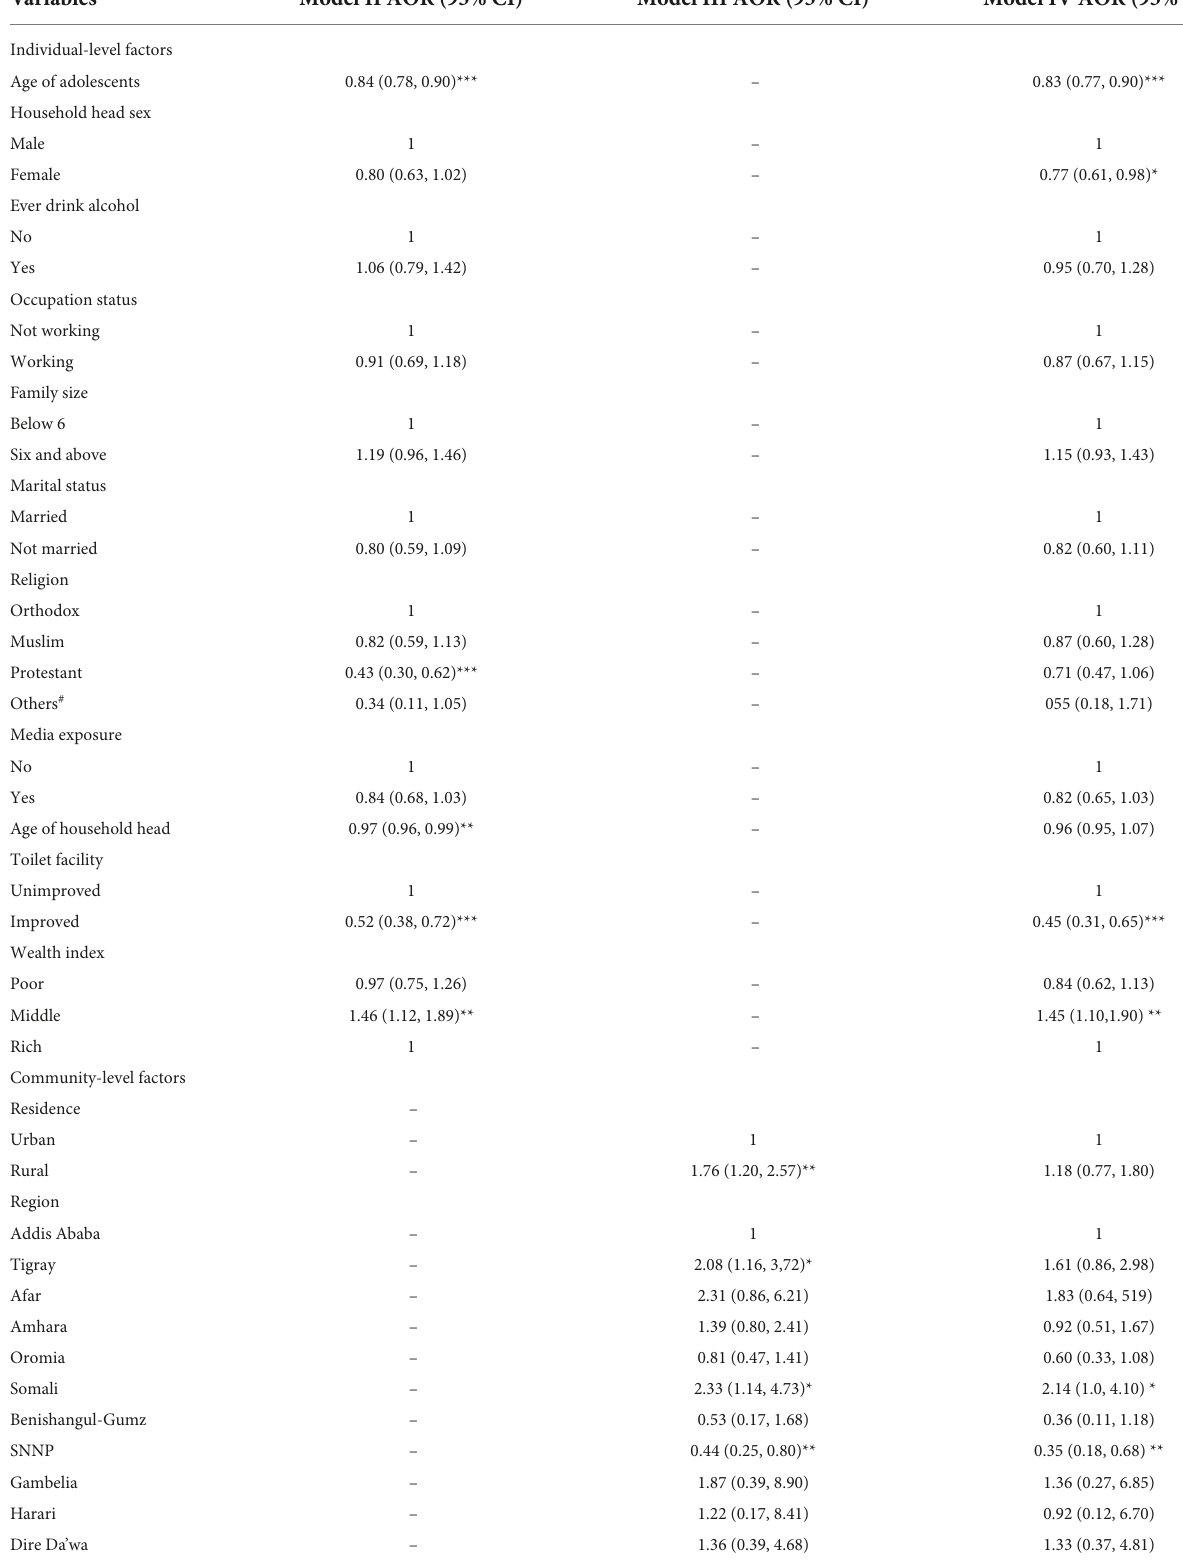
TABLE 5 Factors associated with thinness among late adolescent girls in Ethiopia by multilevel logistic regression analysis, EDHS